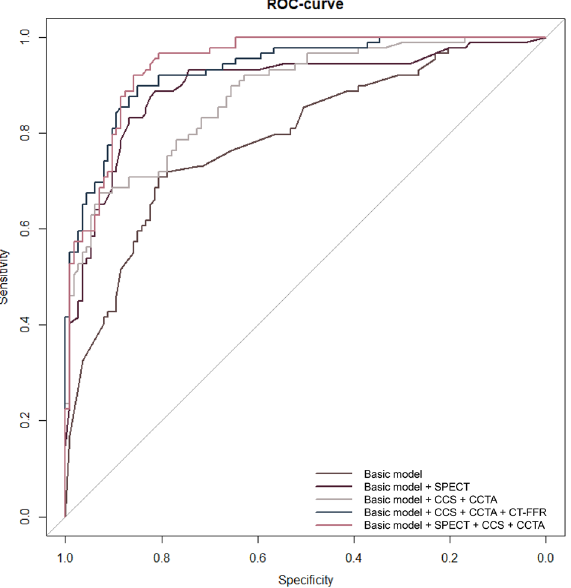
Figure 2. Areas under the Receiver Operator Characteristics curve for all diagnostic model. The basic multivariable model has an AUC of 0.790 and increased to 0.897 upon extension with SPECT. An extension of the basic model with CCTA and CCS increased the AUC to 0.876 and the addition of CT-FFR leads to an AUC of 0.929. The basic model extended with SPECT, CCS and CCTA yielded the highest AUC of